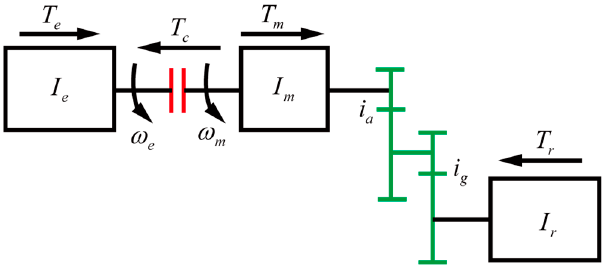
Figure 2. Simplified model sketch of mode transition.